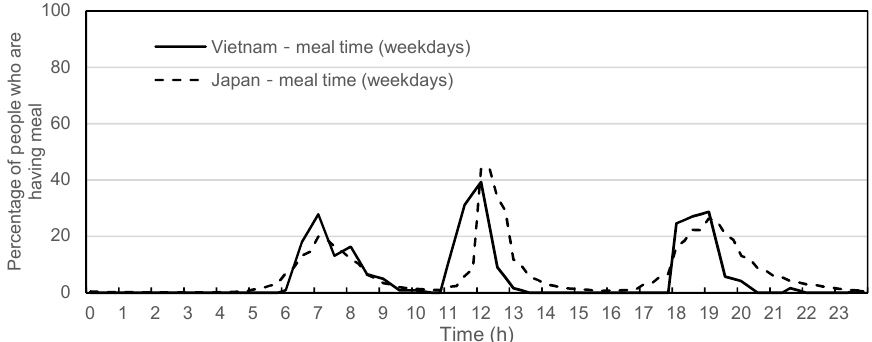
Figure 11. Comparison of breakfast, lunch, and dinner temporal patterns between Japanese and Vietnamese respondents.